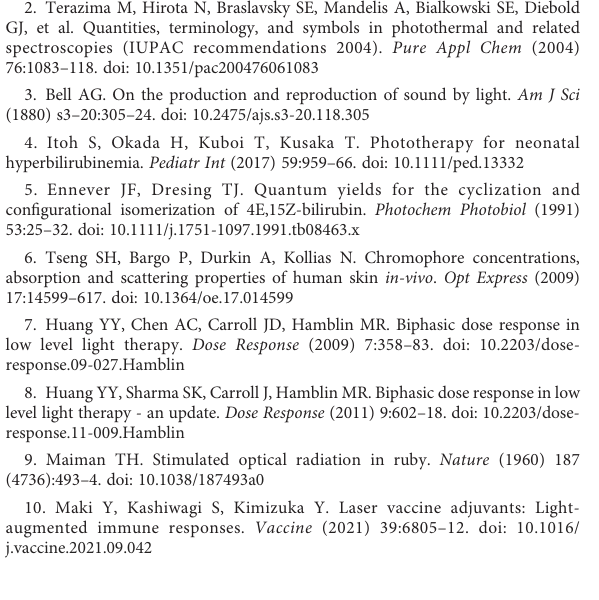
SUPPLEMENTARY FIGURE 1 Longitudinal effect of the near-infrared (NIR) laser adjuvant on anti- in fl uenza immune responses Serum anti-in fl uenza speci fi c (A – G) IgG, (H – N) IgG1, (O – U) IgG2c at day 7-112. n = 14, 14, 18, 16, 14, and 14 for no vaccine (saline), vaccine ID only (ID only), 1064 nm CW laser + vaccine ID, 1270 nm CW laser + vaccine, vaccine/alum ID (Alum), and vaccine IM, respectively. Results were pooled from three independent experiments and analyzed using the Kruskal – Wallis test followed by the Dunn ’ s multiple comparisons test. (* p <0.05, ** p <0.01, *** p <0.001, **** p <0.0001 compared with ID only) Geometric mean with 95% CI. Data of day 21 and 56 from are shown for